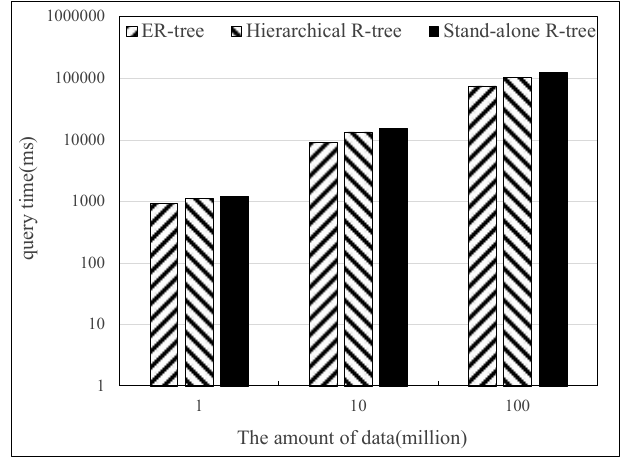
Figure 13. Comparison of the index range query performance on the simulated dataset. Simulated dataset circle query: For each database with different amounts of data after building the index, this paper performed 1000 random circle queries with various query radii and calculated the average query time to compare the query performance of the index. The experimental results are shown in Figure 14. The vertical coordinate is the logarithmic axis. The result shows that the ER-tree index has better circle query performance than the other two, for the same reason as the point query.